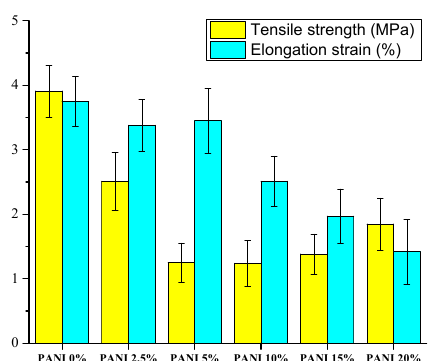
Figure 6. E ff ect of adding PANI on the mechanical properties of the electrospun PANI / SF mats. The textiles’ surface showing hydrophobicity is desirable for preventing fabrics from wetting.